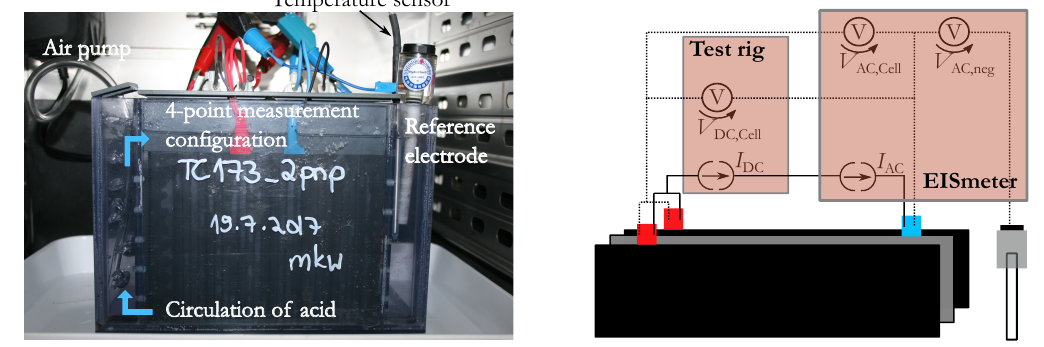
Figure 1. On the left side, the lead-acid test cell in a PVC box is equipped with a reference electrode and a temperature sensor. Air is pumped into the left side compartment and the ascending air bubbles mix the acid. The electrodes are connected in a 4-point measurement configuration for EIS . On the right side, a schematic representation of connections with the testing apparatus is